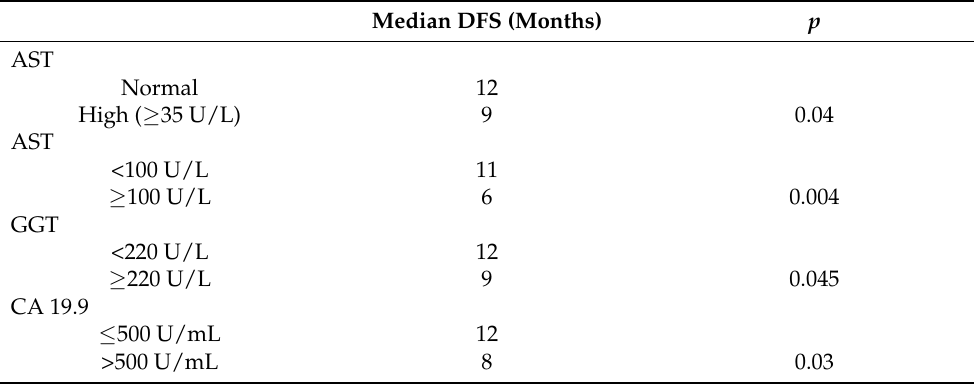
Table 3. Variables influencing disease-free survival. Abbreviations—AST: aspartate aminotrans- ferase; ALT: alanine aminotransferase; GGT: gamma-glutamyl transferase; CA 19.9: carbohydrate antigen